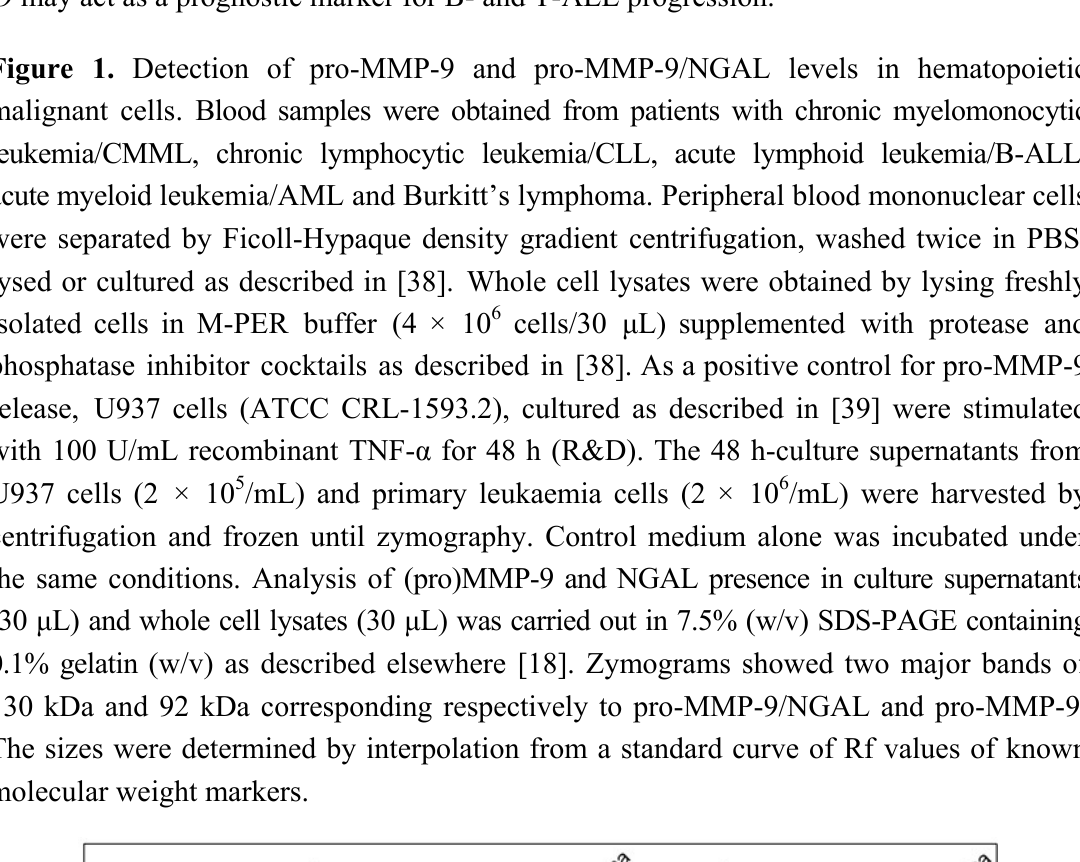
Figure 1. Detection of pro-MMP-9 and pro-MMP-9/NGAL levels in